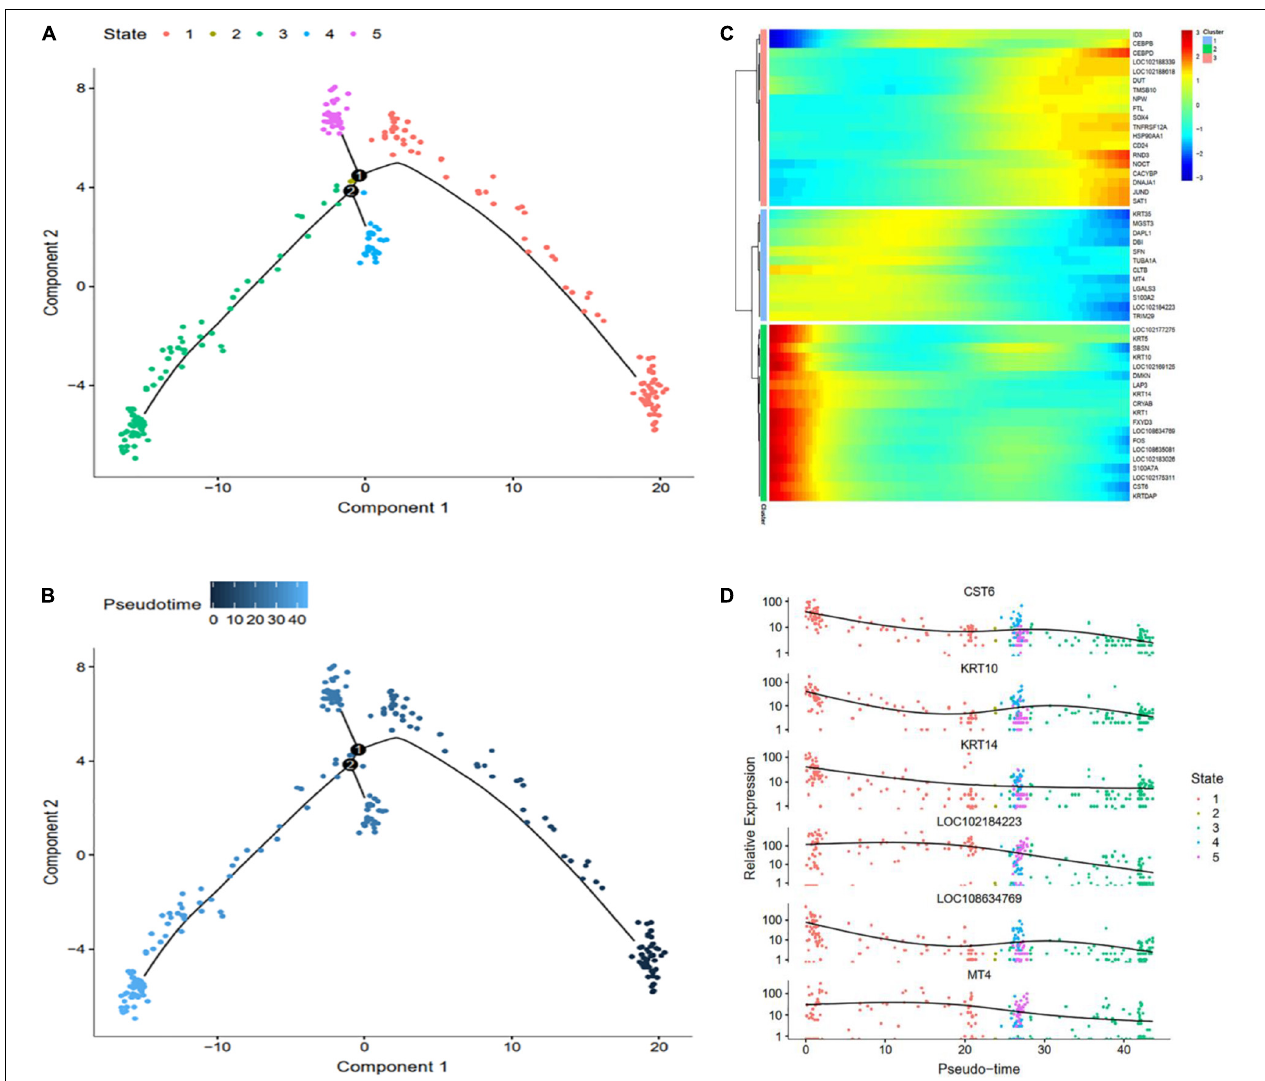
FIGURE 7 | Cell trajectory analysis in DPCs of goat skin. (A) Monocle 2 cell trajectory of goat DPCs. (B) Pseudo-time is displayed in a dark to light blue gradient and indicates the start of pseudo-time. (C) Clustering of top 50 genes exhibiting in DPCs. (D) Expression levels of six responsive genes in DPCs. X -axis represents pseudo-time, Y -axis represents gene expression